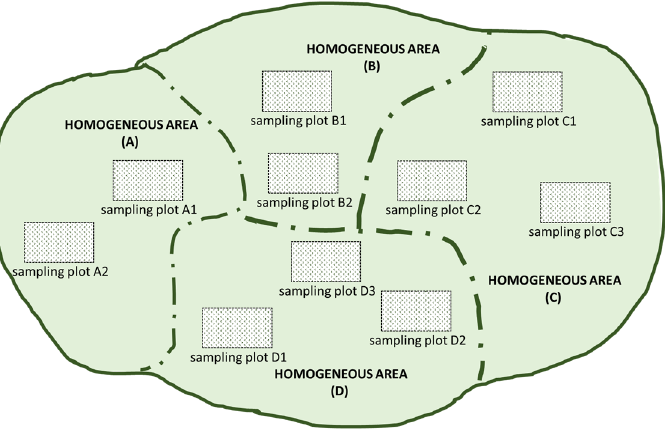
Figure 3. Example of the identification of the homogeneous areas and sampling plots.